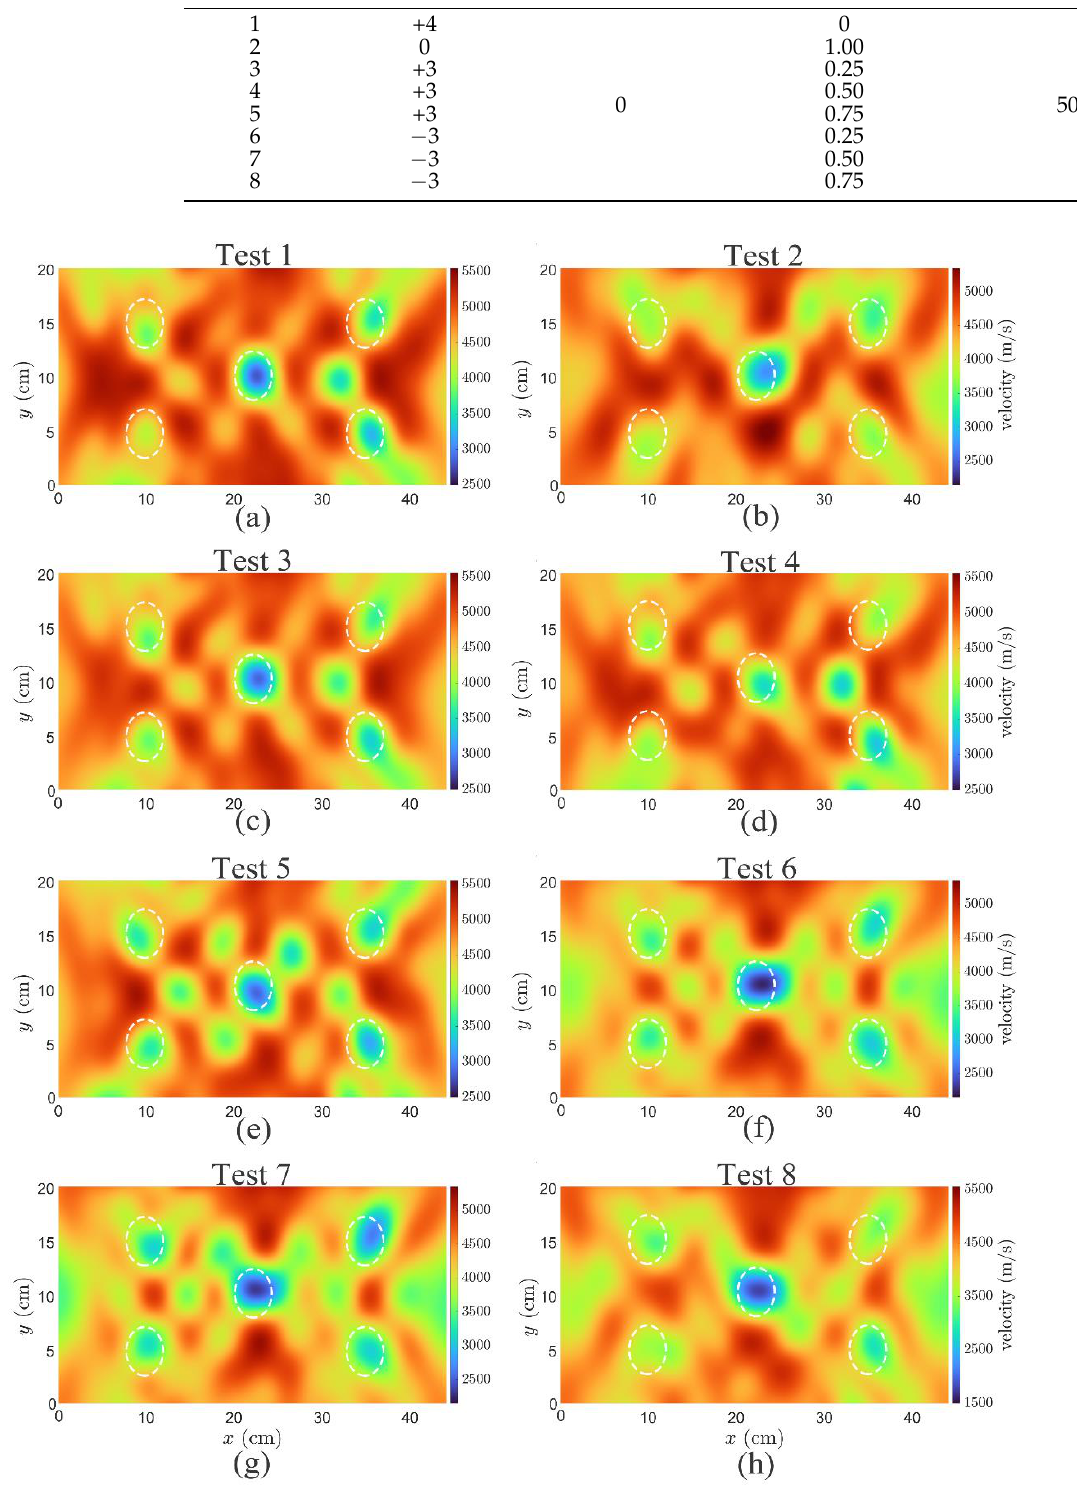
Figure 14. Tomographic results of FAAT in robustness tests with different systematic errors and random noises. Different color bars are used in the visualization results due to the large variation in wave velocity. The white dotted lines delineate the original anomalous areas.